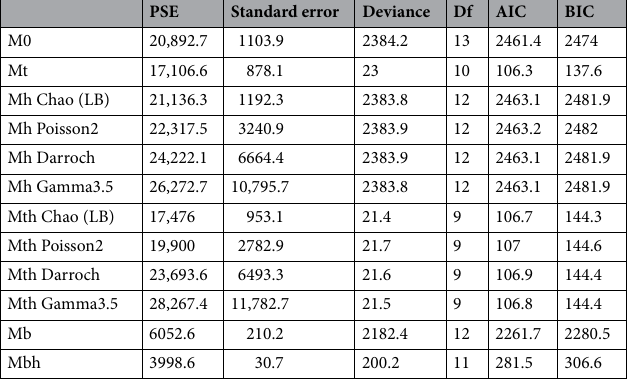
Table 3. Capture–recapture PSE results using log-linear models and assuming closed